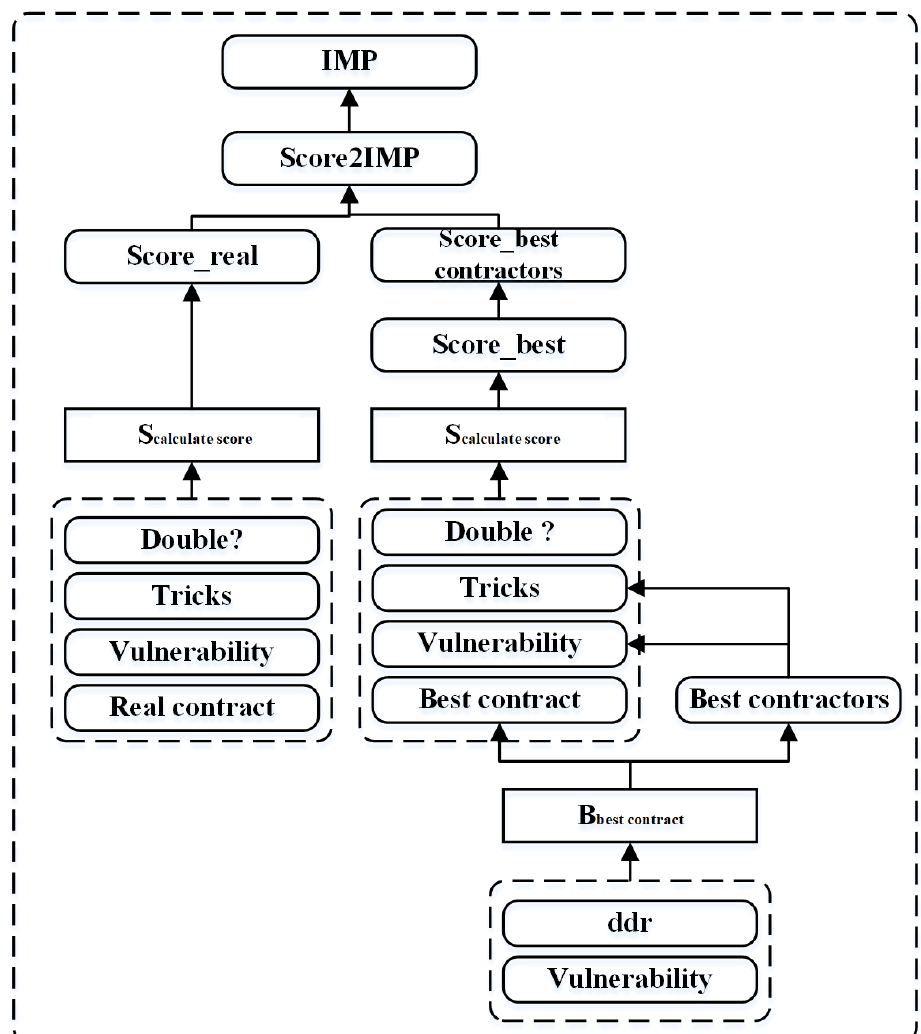
Figure 7. A flowchart to compute